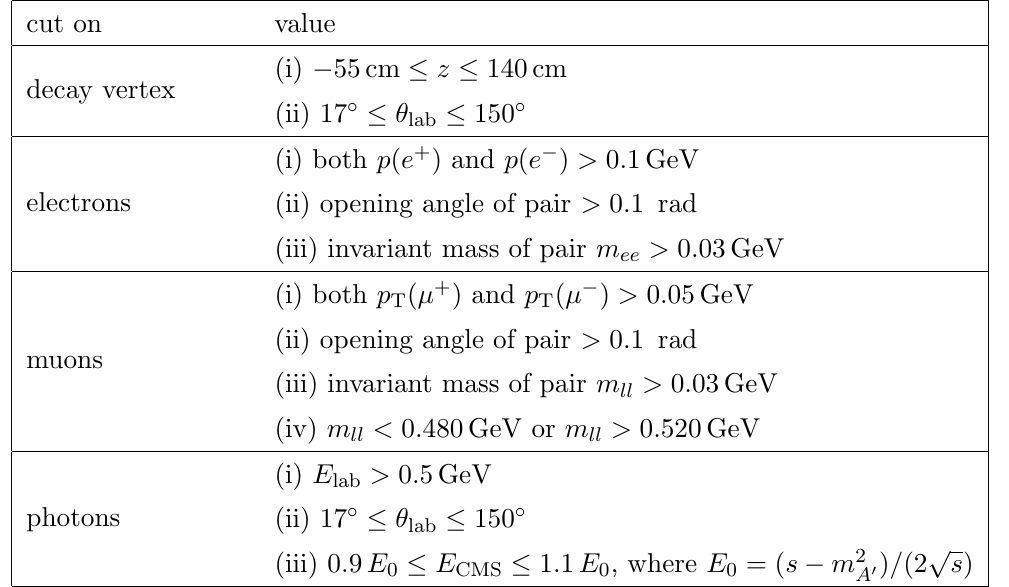
Table 4 . Selections used in the displaced vertex